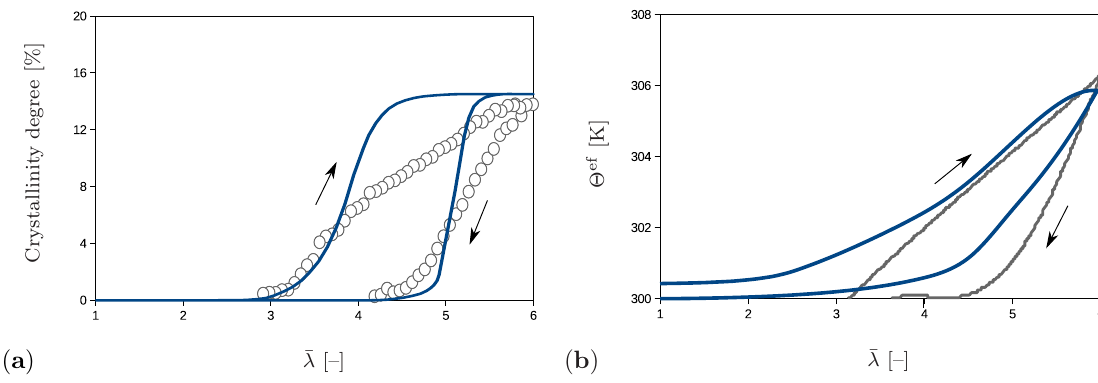
Figure 12. Comparison of the experimental results (in grey) and numerical results (in blue) for ( a ) the crystallinity degree and ( b ) the temperature